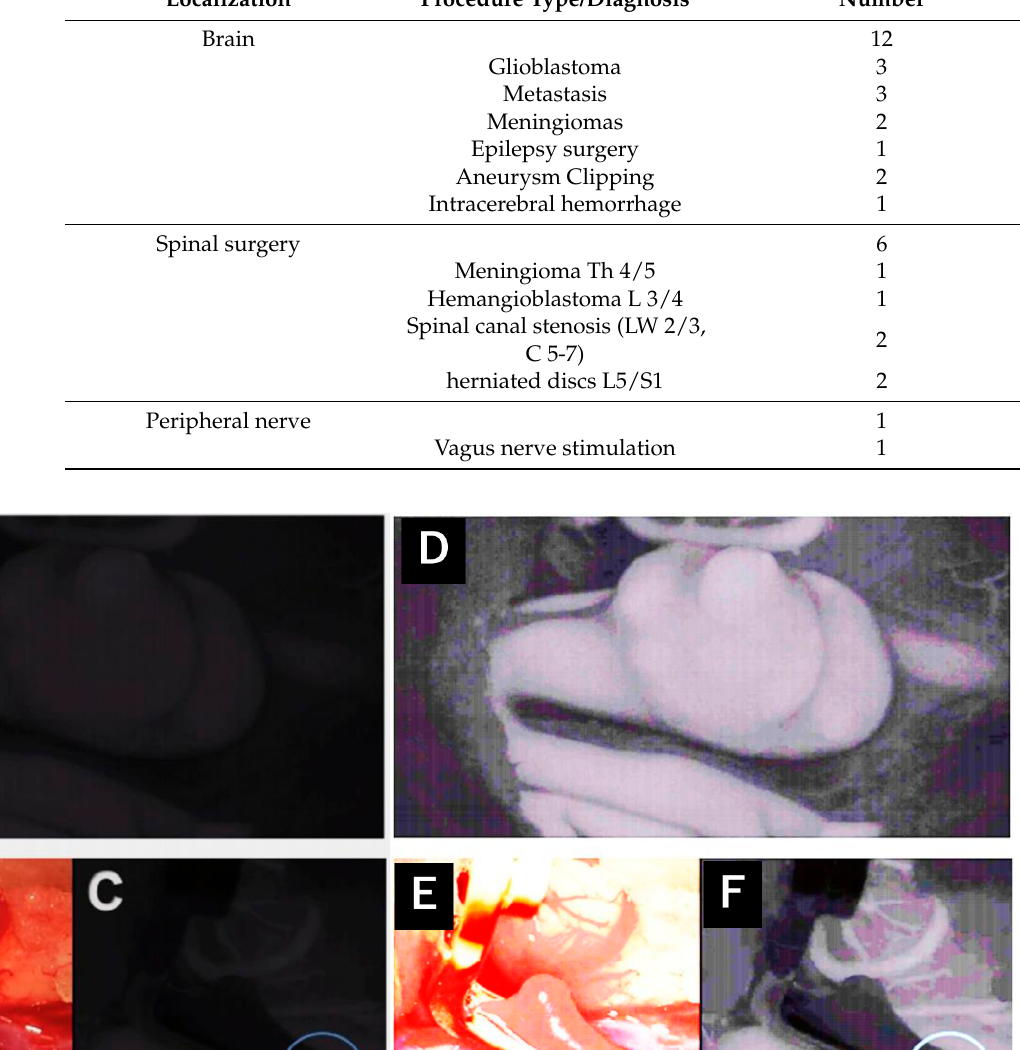
Figure 5. Evacuation of an intracerebral hemorrhage with the assistance of tubes. Intraoperative visualization of the hemorrhage during Aeos surgery.